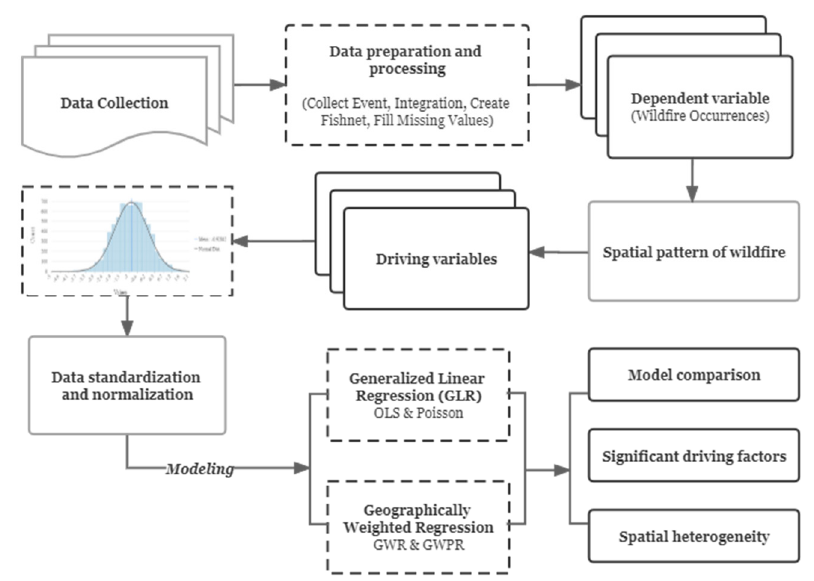
Figure 2. The logical framework of the study.